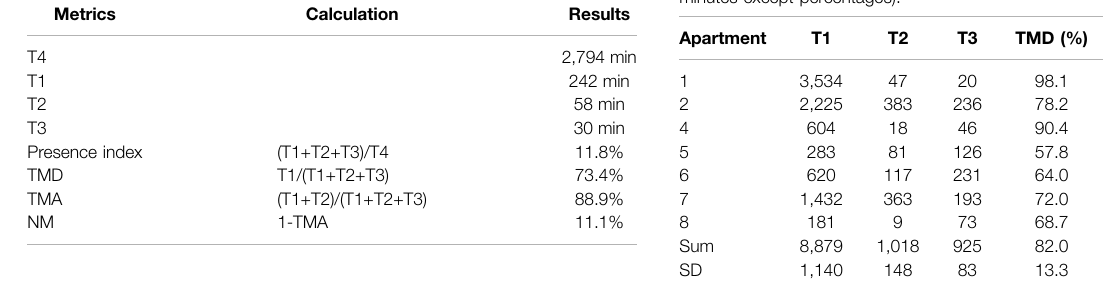
TABLE 6 | Summary of the time-matching levels in all apartments (all numbers in minutes except